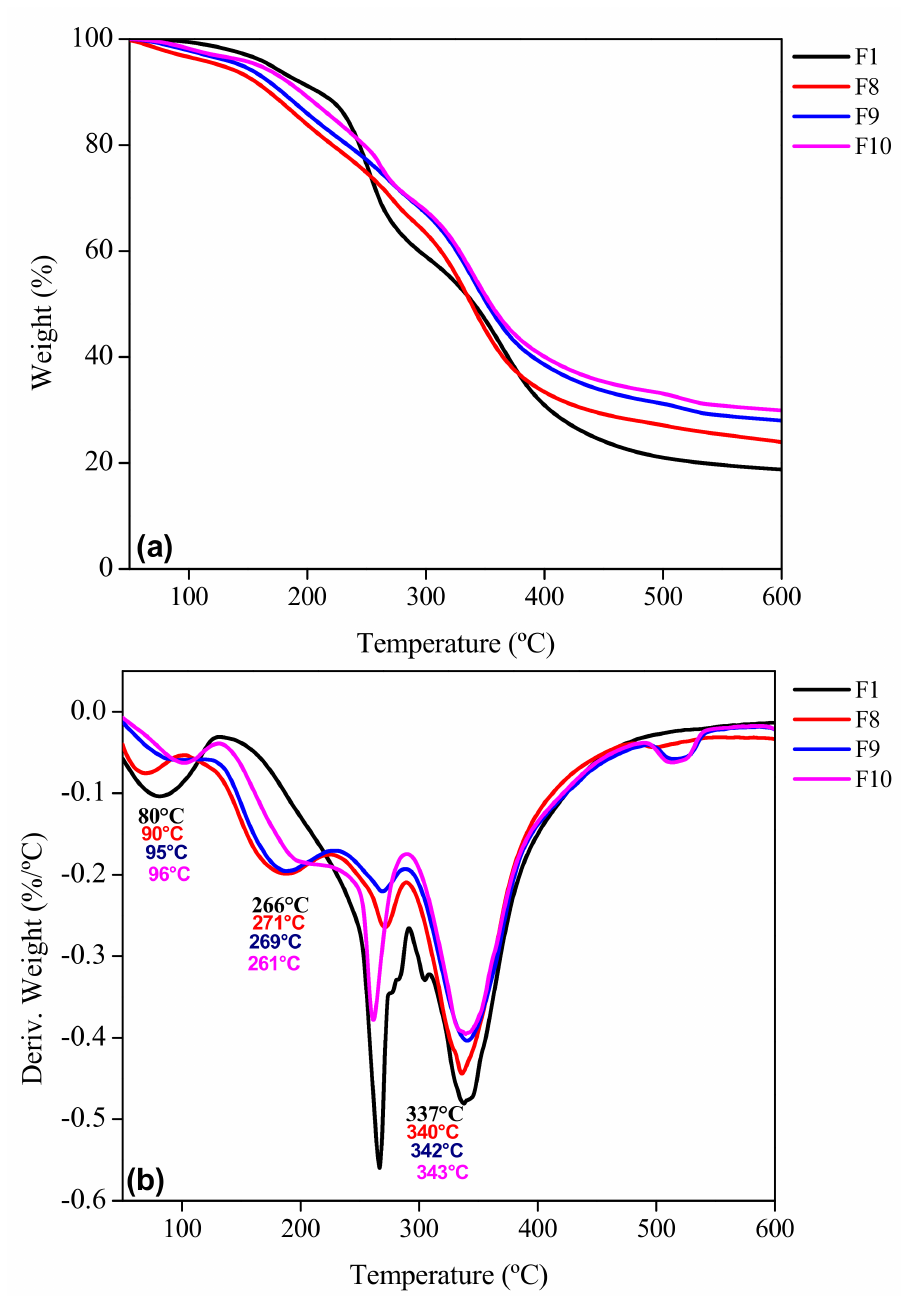
Figure 10. TGA profile of the reinforced gelatin biofilms. ( a ) Weight as a function of temperature and ( b ) first derivative of the weight curve. F1: control biofilm; F8–F10: biofilm with microfiber and